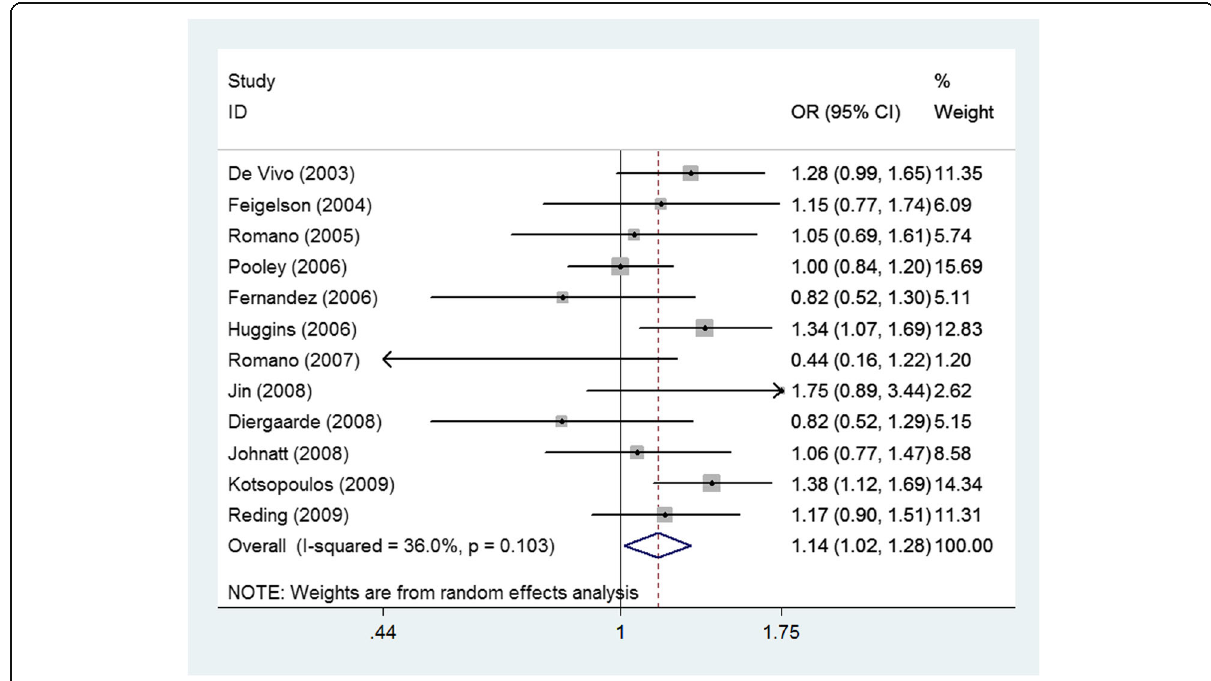
Fig. 1 Forest plot of the association between +331G/A in the PGR gene and breast cancer in a dominant model (AG + AA vs. GG)